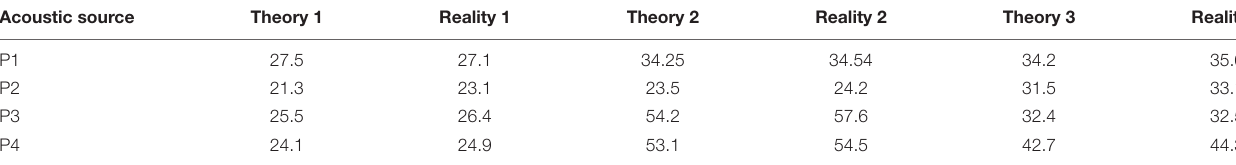
TABLE 1 | Time delay forecast results.